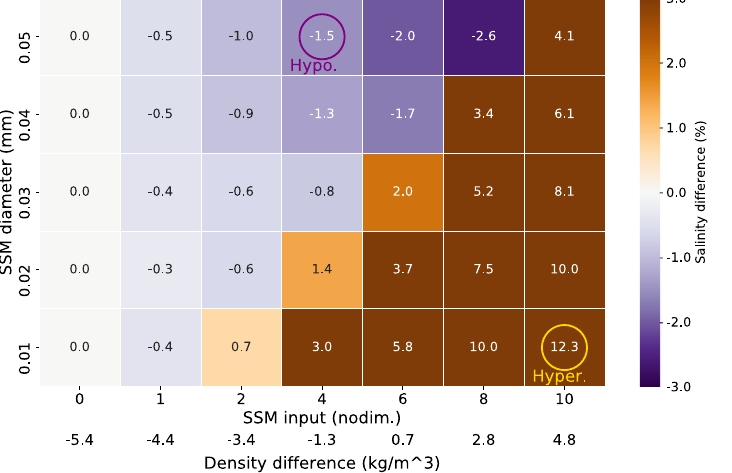
Figure 4. Mean salinity differences from WOS in the surface (the top two layers) river plume area (salinity ≤ 28.0), in sensitivity experiments with respect to changes in SSM input (x-axis) and diameter (y-axis), at the times of maximum differences. The SSM inputs of the x-axis are normalized by those of STD. Numbers on the lower x-axis are the density differences between river water and seawater, approximately calculated from the maximum amounts of input SSM and freshwater, temperature, and salinity in the initial state. Negative values (blue color) indicate lower salinity (i.e., a more intense hypopycnal plume) than WOS, whereas positive values (brown color) denote higher salinity (i.e., a hyperpycnal plume). The purple circle marks a typical hypopycnal case and the yellow circle a typical hyperpycnal one. nodim .